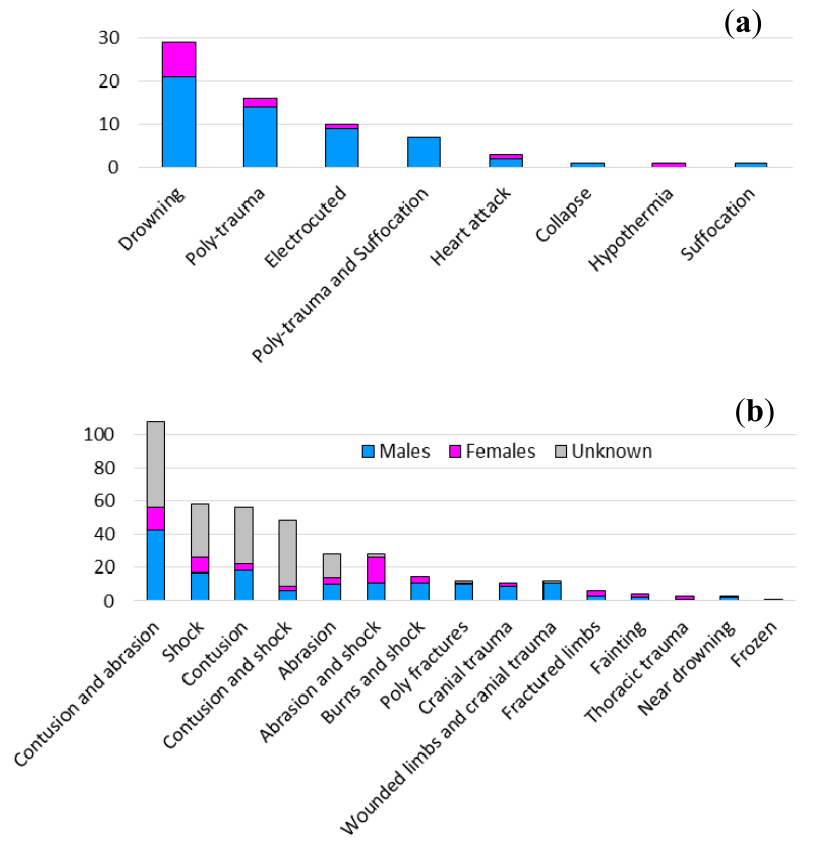
Figure 7. Gender, causes of death ( a ) and type of injured ( b ) (See also Appendix A: Table A3). The colours of the legend are the same for both diagrams.